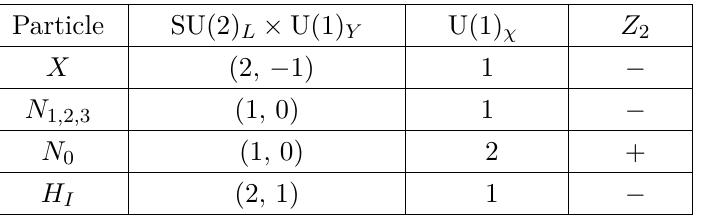
Table 1 . Representations and charyge assignments of the introduced